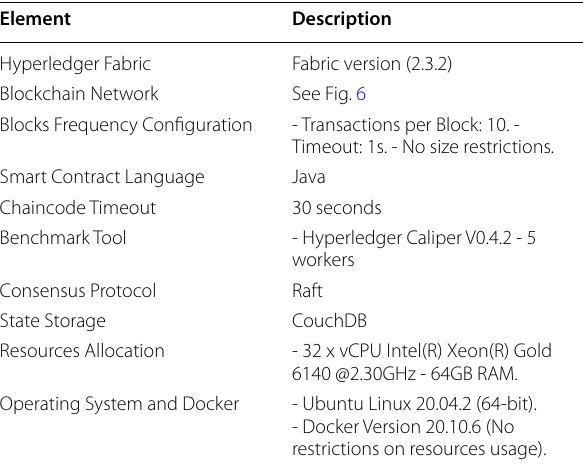
Table 2 Blockchain deployment and configurations